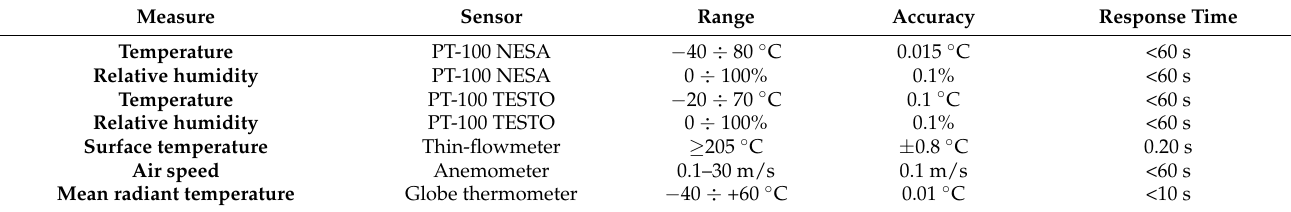
Table 3. Technical specifications of the inner sensors.